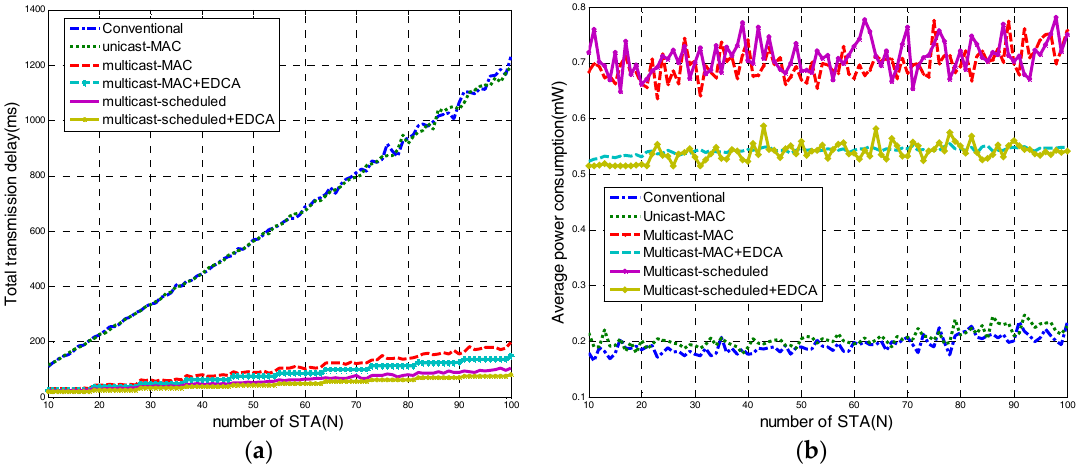
Figure 13. The total transmission delay and average power consumption as the number of STA increased. ( a ) Total transmission delay; ( b ) average power consumption. EDCA = enhanced distributed channel access.